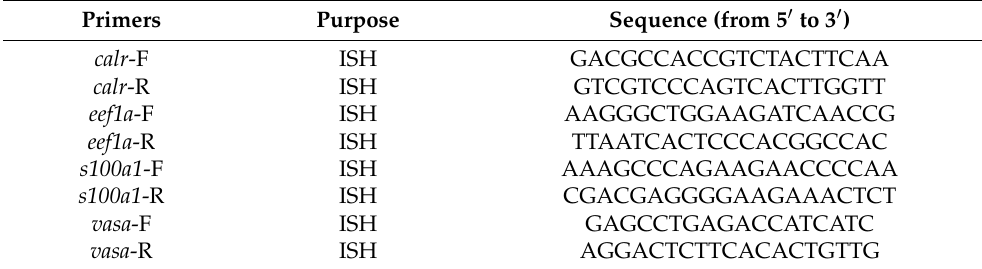
Figure 6. Validation of the selected marker genes. ( a ) Heatmap of eight selected marker genes in previous RNA-seq data. ( b ) Calr mRNA expression in testis, ( c ) a higher magnification view of the box area in ( b , d ) negative contrast hybridized by calr sense probes. ( e ) Eef1a mRNA expression in ovary, ( f ) eef1a mRNA expression in testis, ( g ) a higher magnification view of the box area in ( f , h ) negative contrast hybridized by eef1a sense probes. ( i ) S100a1 mRNA expression in ovary, ( j ) s100a1 mRNA expression in testis, ( k ) a higher magnification view of the box area in ( j , l ) negative contrast hybridized by s100a1 sense probes. ( m ) Vasa mRNA expression in ovary, ( n ) vasa mRNA expression in testis, ( o ) Vasa antibody expression in ovary, ( p ) Vasa antibody expression in testis. PO, primary-growth stage oocyte; PVO, cortical-alveolus stage oocytes; VO, vitellogenic stage oocytes; SG, spermatogonium; SC, spermatocyte; ST, spermatid; SZ, spermatozoon. Scale bar = 50 µ m. Table 1. The primers used in the present